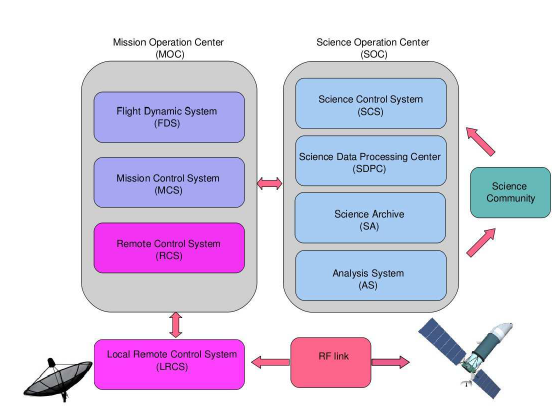
Figure 4: Basic layout of WSO-UV ground